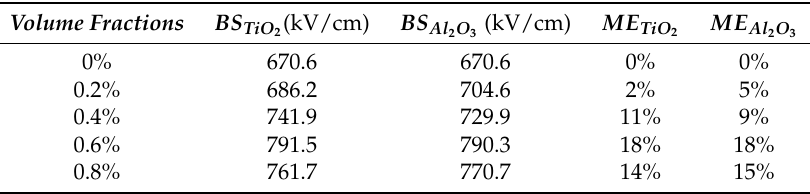
Figure 6. Weibull distribution of pure transformer oil and nano-liquids’ breakdown strength with volume fractions of added TiO 2 nano-particles and Al 2 O 3 nano-particles ranged from 0.2% to 0.8%. Table 1. The average breakdown strength and modification effect of TiO 2 and Al 2 O 3 nano-liquids. BS represents the average breakdown strength, which is expressed in units of (kV/cm), and ME represents the modification